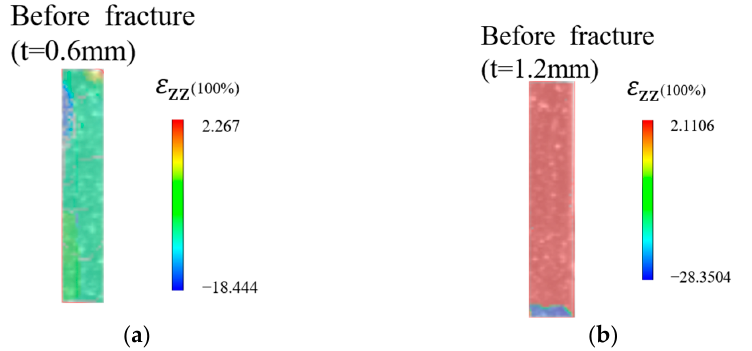
Figure 13. Full-field strain ε zz contour maps of the thin-walled specimens before rupture tested at 980 °C/250 MPa: ( a ) 0.6 mm thick specimen, ( b ) 1.2 mm thick specimen.